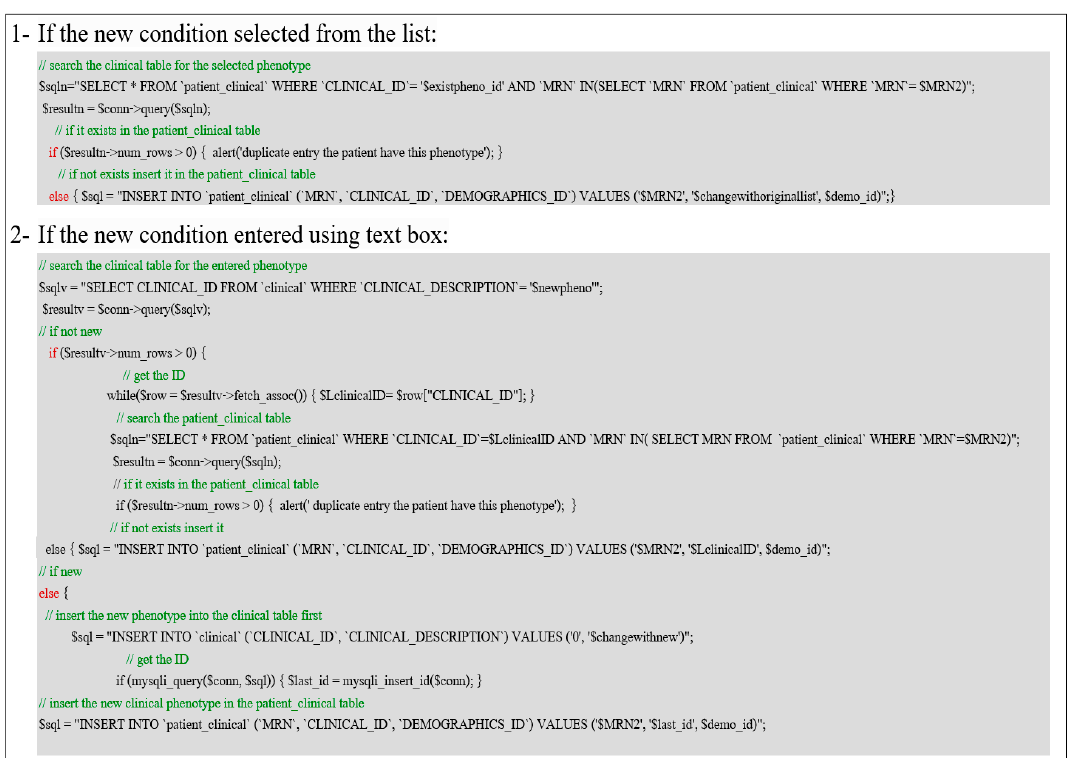
Figure 17. The script for updating patient information by adding a new clinical phenotype.